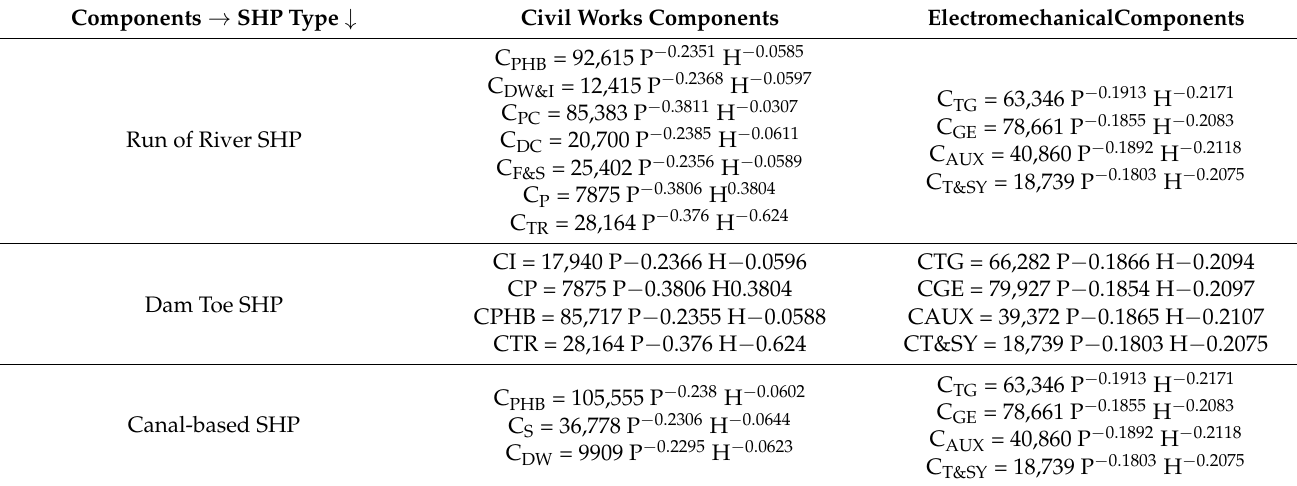
Table 4. Correlations for cost components of low head SHP plants